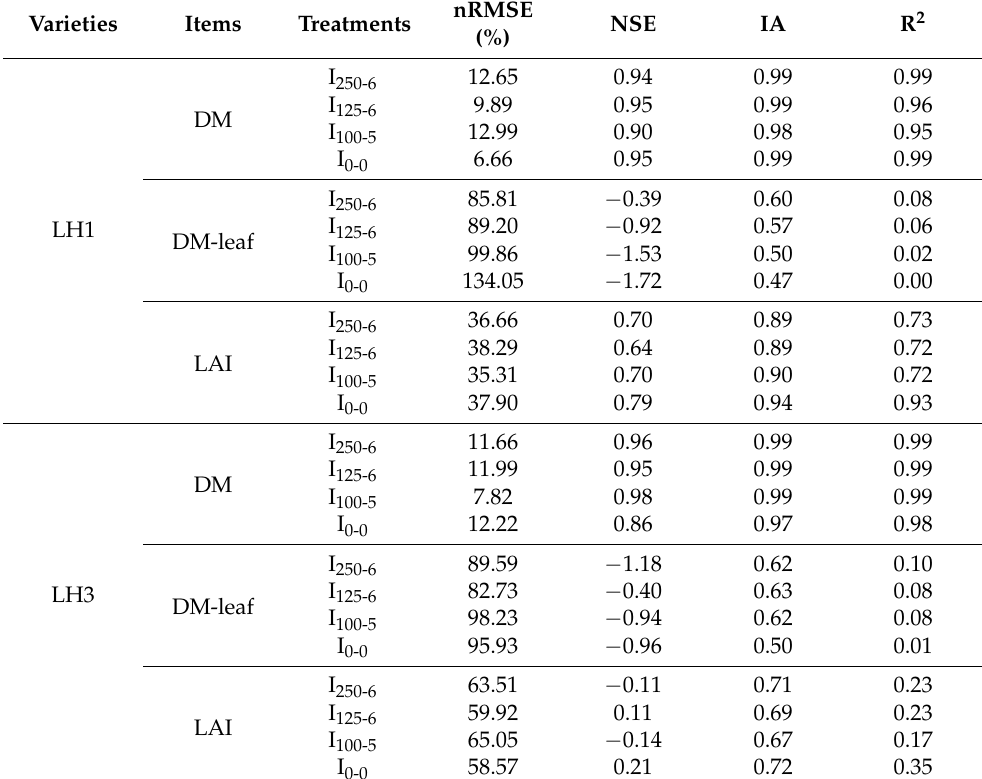
Table 3. Statistical criteria for simulation of LAI, DM (the dry matter weight of root, stem and grain) and DM-leaf (the dry matter weight of leaf) under different irrigation schedules of LH1 and LH3 in 2020.